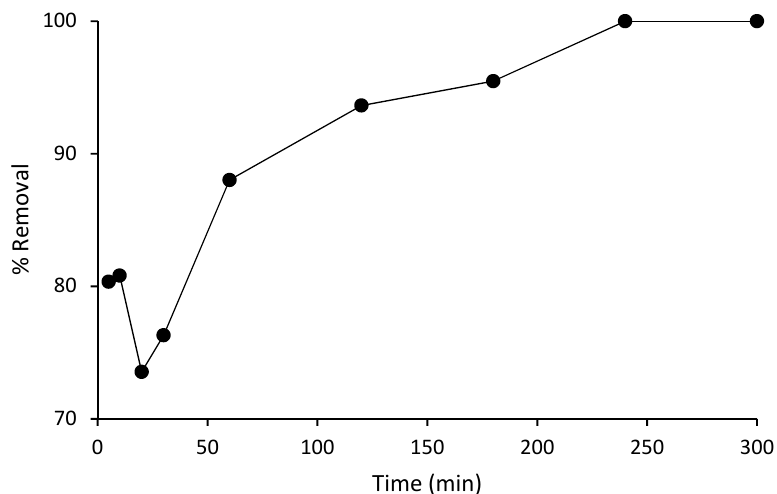
Figure 7. Breakthrough curve after desorption.